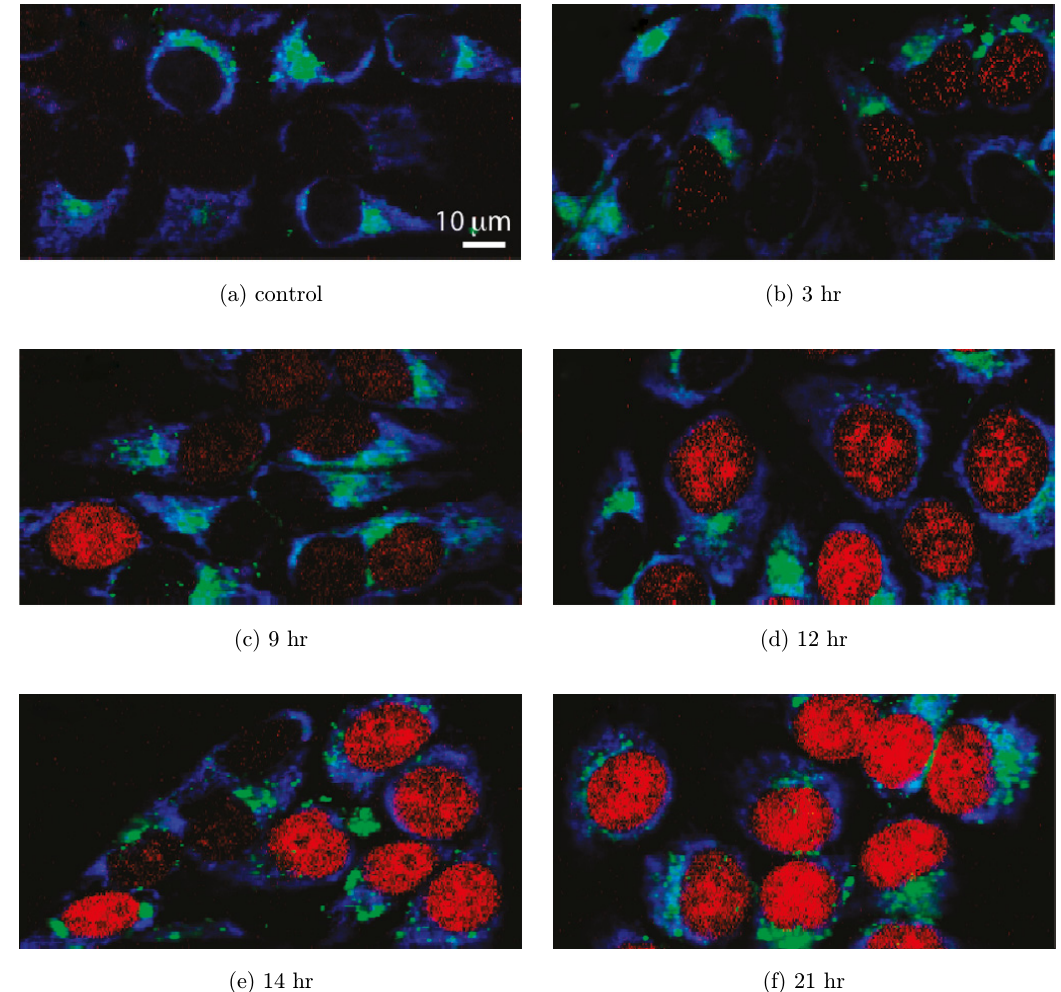
Fig. 6. Time-course Raman images of HeLa cells cultured with alkyne labels, which emit in the Raman silent region (2123 cm (cid:1) 1 ). The overlay was constructed with 749, 2123 and 2849 cm (cid:1) 1 bands, shown respectively as blue, red and green. Reprinted with permission from Ref. 26. Copyright (2011) American Chemical